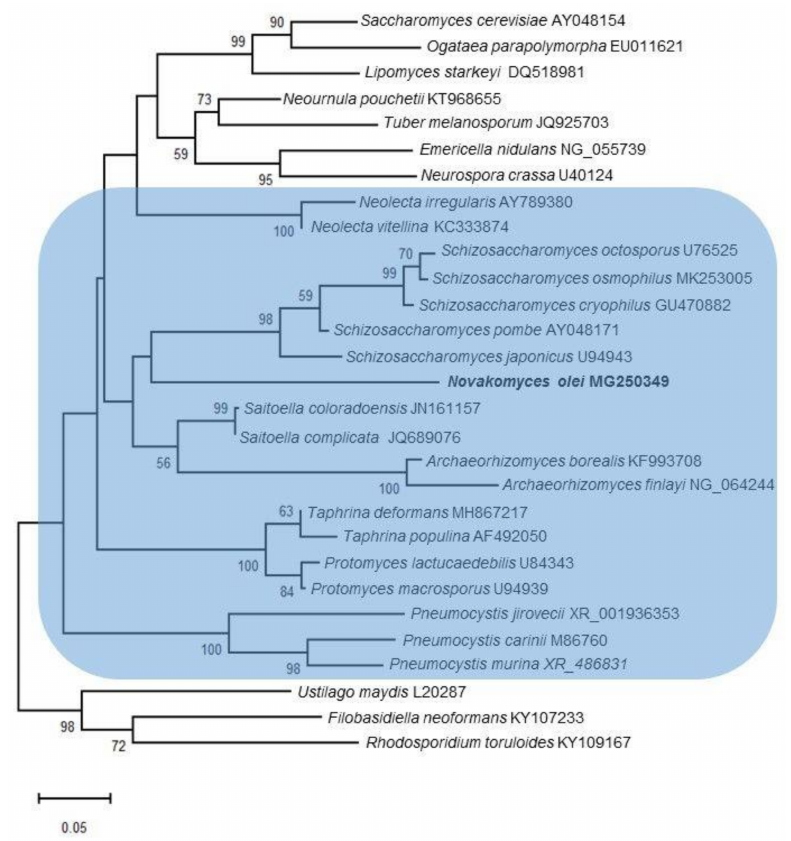
Figure 1. Phylogenetic placement of Novakomyces olei sp. nov. in the subphylum Taphrinomycotina using maximum- likelihood analysis and the Tamura–Nei model [73]. A discrete Gamma distribution was used to model evolutionary rate differences among sites. Analysis was performed based on the sequences of the LSU rRNA gene D1/D2 domain. Bootstrap percentages (1000 replicates) exceeding 50% are given at branch nodes. Bar, 5% nucleotide sequence divergence. Ustilago maydis , Filobasidiella neoformans , and Rhodosporidium toruloides were used as the designated outgroup species. Taphrinomycotina is highlighted by the blue